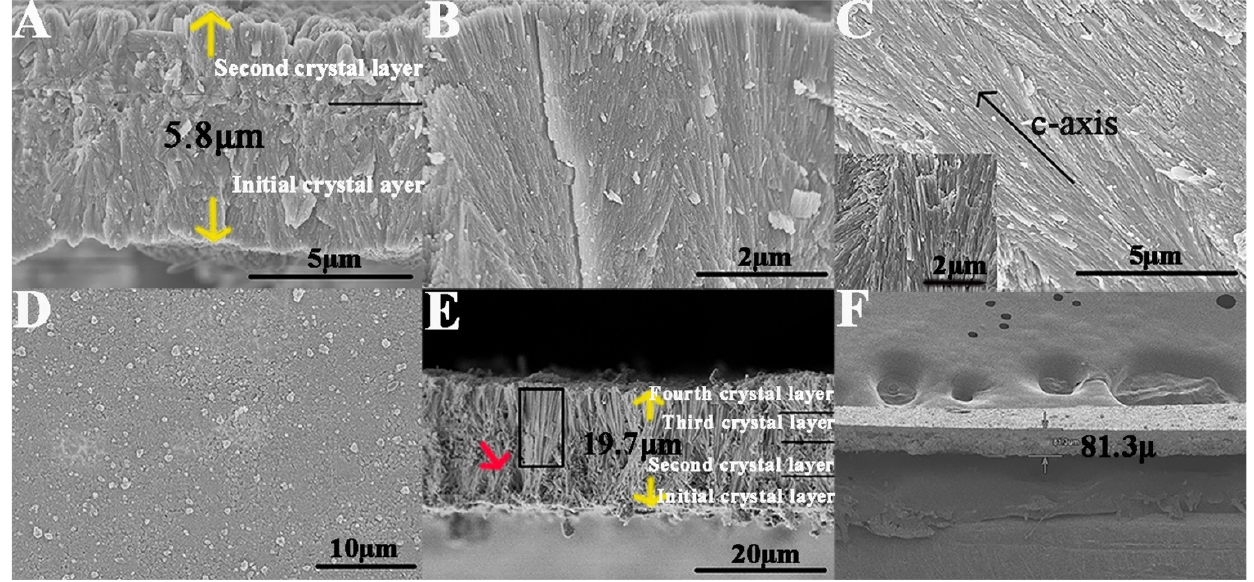
Figure 6. Scanning electron microscopy (SEM) evaluations of the synthesized biofunctional materials. ( A ) Transversal section of the synthesized material fabricated with two cycles of mineralization and LBL deposition. ( B , C ) Magnified micrographs of ( A ). The inset in ( C ) shows the prismatic struc- ture of native enamel. ( D ) Surface micrograph of the second crystal layer in the synthesized material. ( E ) Transversal micrograph of the synthesized material fabricated with four mineralization and layer-by-layer deposition cycles. The arrow in red represents the formation of new crystals, and the rectangle represents the overgrowth of the original crystals. ( F ) Image of the final synthesized ma- terial after 10 cycles.